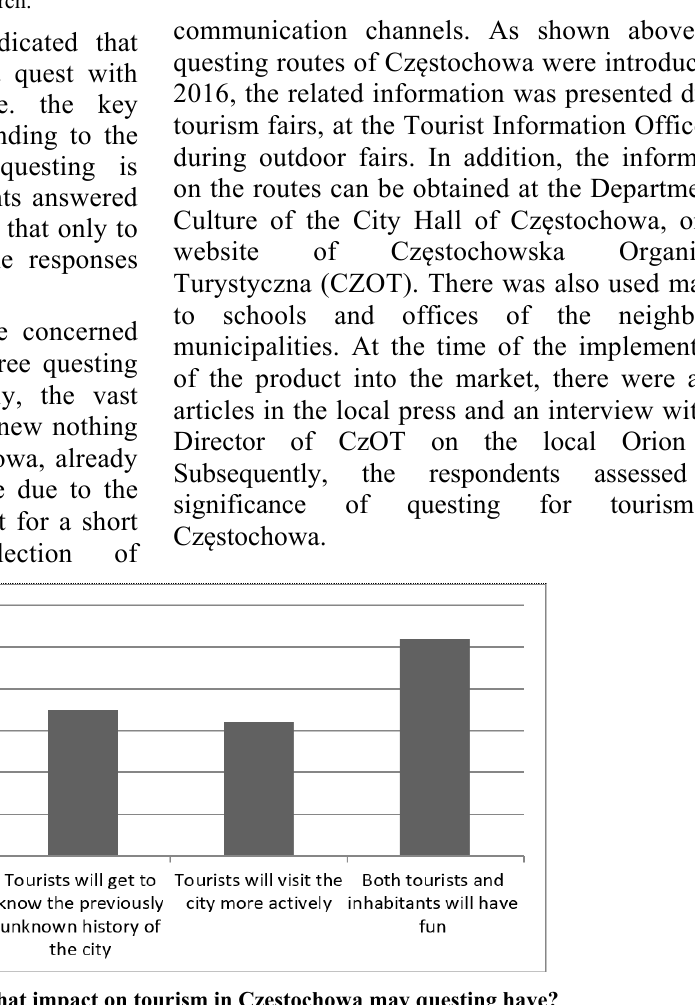
Fig. 5. In your opinion, what impact on tourism in Częstochowa may questing have? Source: Own study based on the conducted